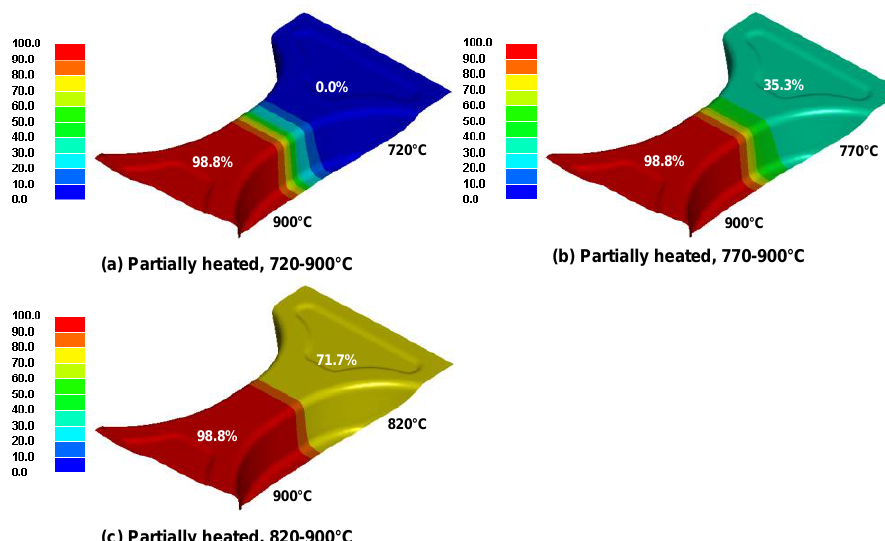
Figure 8. Predicted fraction of austenite according to the heating temperature.